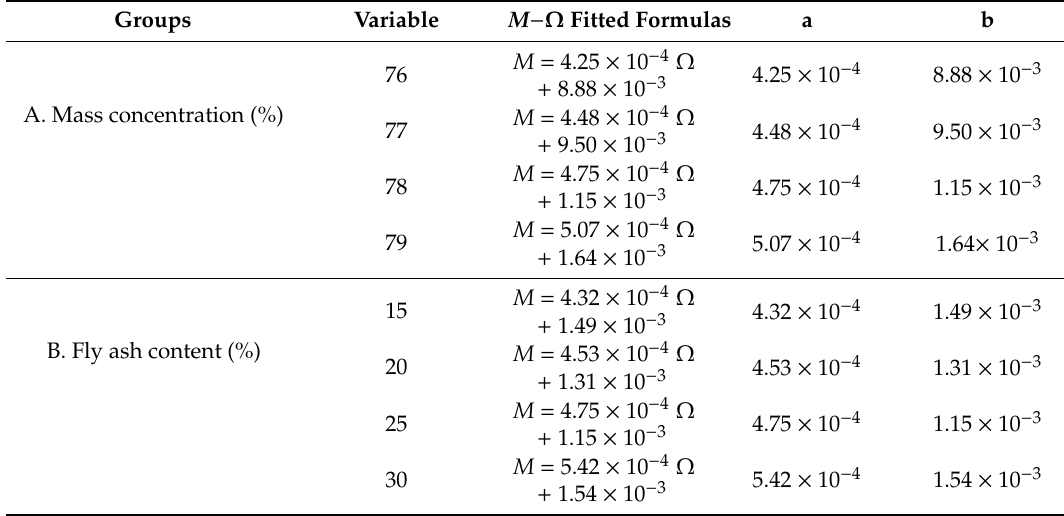
Table 2. M − Ω relationship.